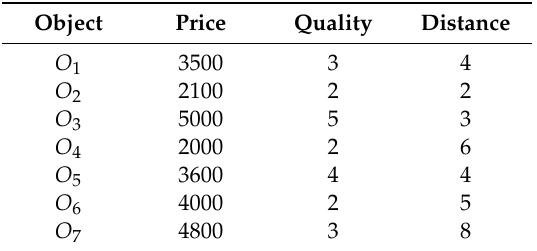
Table 1. Objects owned by P 1 .